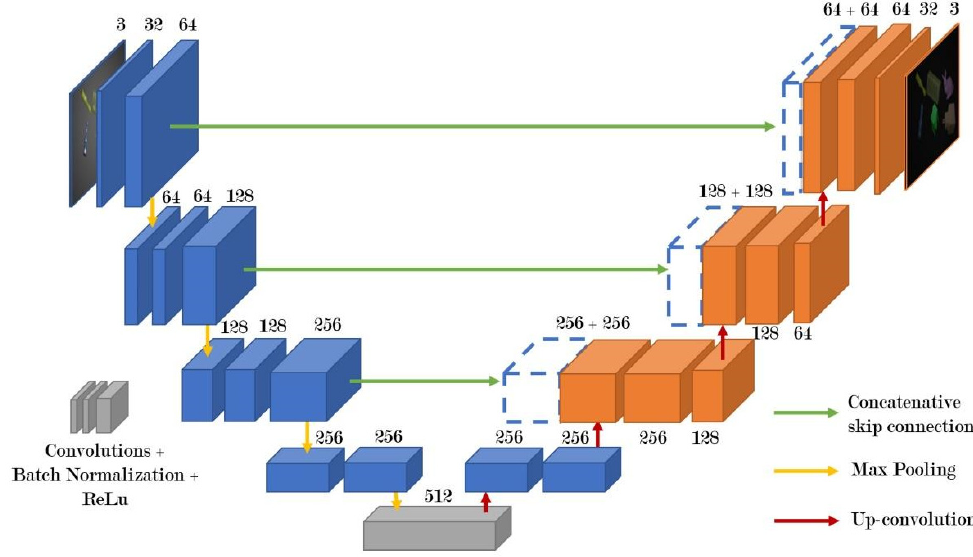
Figure 12. Modified U-Net architecture.